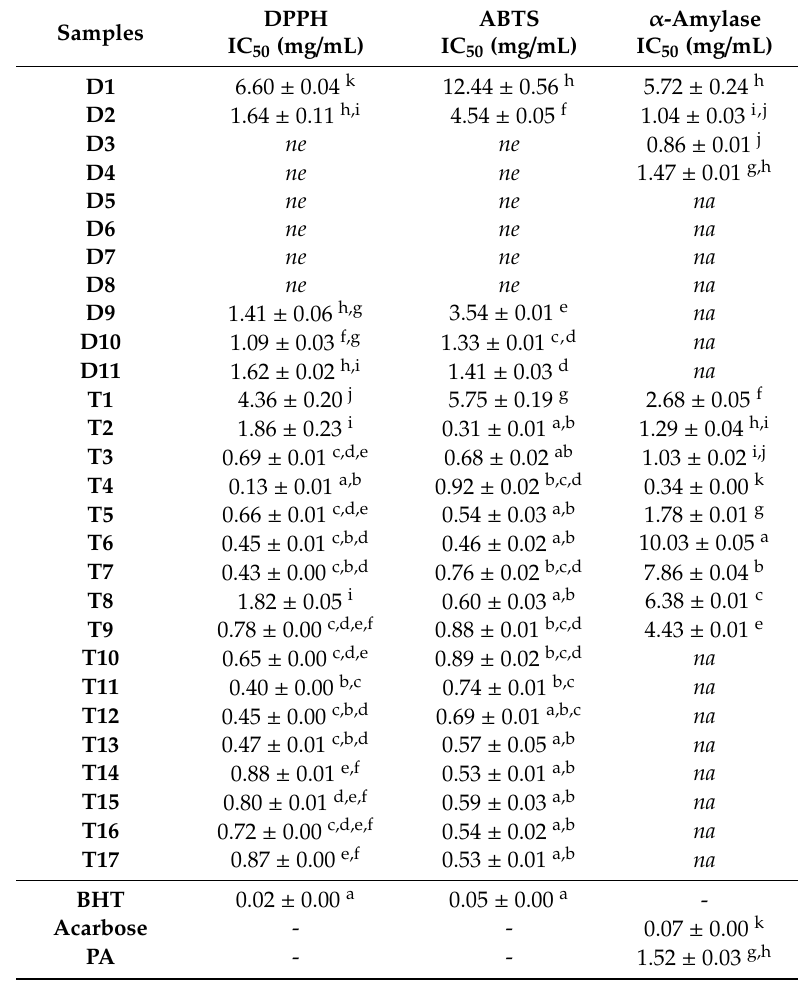
Table 4. Antioxidant activity of fractions isolated from MH and ME extracts.